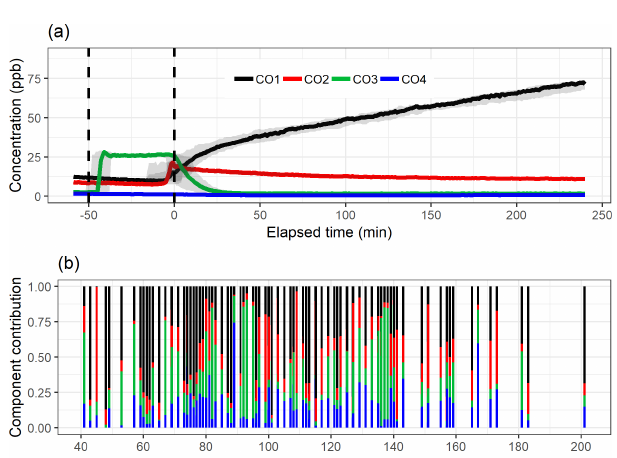
Figure 4. The component time series (a) and contribution (b) for EVD-PCA with oblimin rotation for the four-component solution. Shaded areas in the time series indicate the component range for the bootstrap resamples; solid lines are for the measured gas- phase (PTR-MS) data. The colour code identifying components is the same in both panels. Components were identified as later- forming and slowly forming products (CO1), early products (CO2), α -pinene precursor (CO3), and background or car exhaust precur- sor